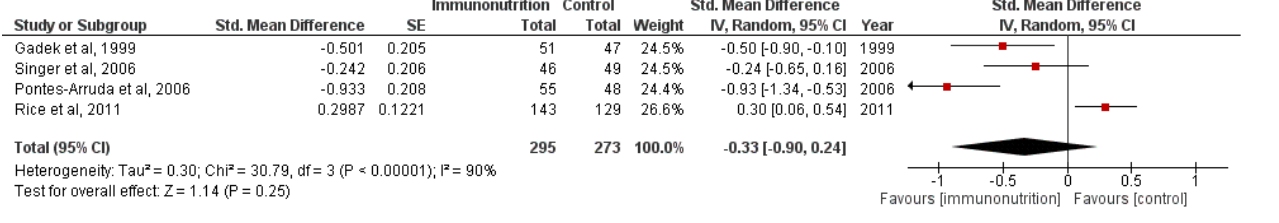
Figure 4. Forest plot of the association between enteral immunomodulatory diet and 28-day ventilator-free days among patients with ALI/ARDS.